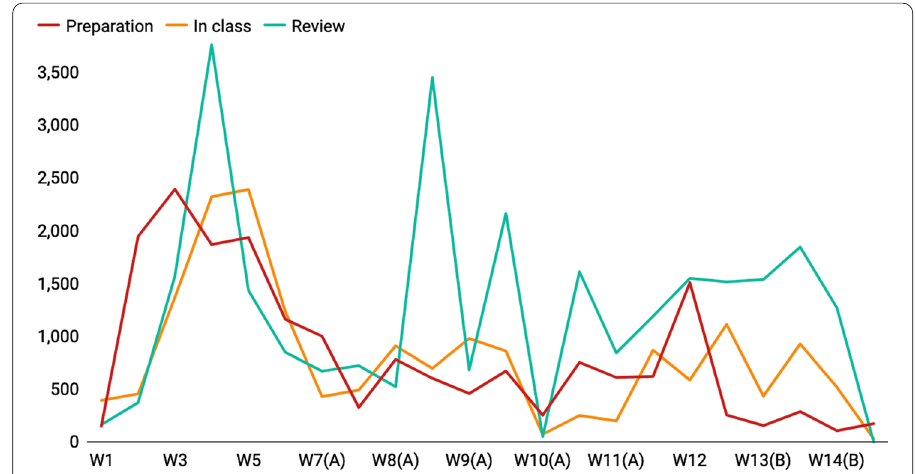
Fig. 10 Number of complete-jumps across 14 weeks. Y-axis: number of complete-jumps, X-axis: weeks